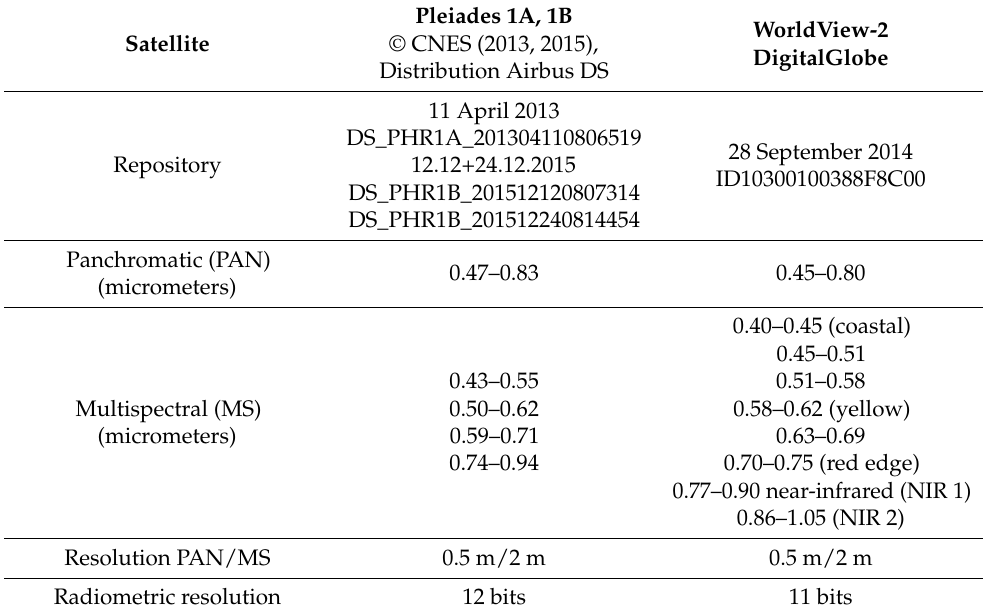
Table 1. Characteristics of satellite data used in the